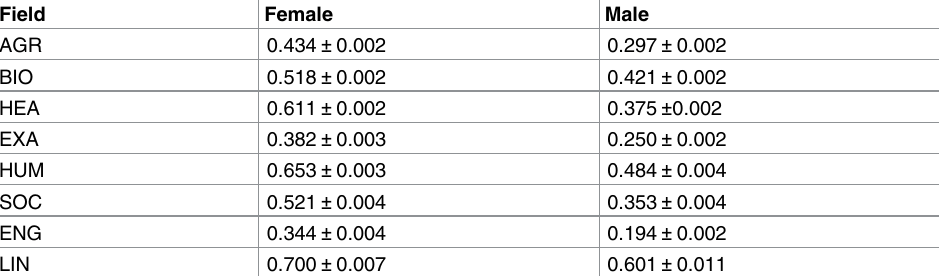
Table 3. Average g-ratio for men and women for the eight major fields. Same abreviations for the fields as in Table 2.